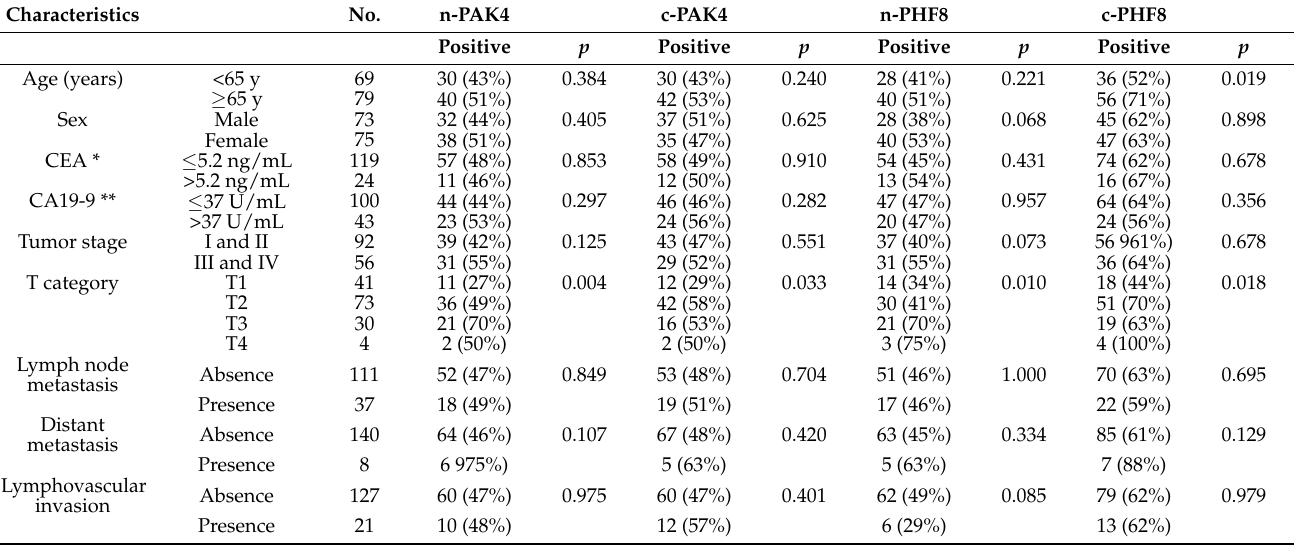
Table 1. The expression of PAK4 and PHF8 in